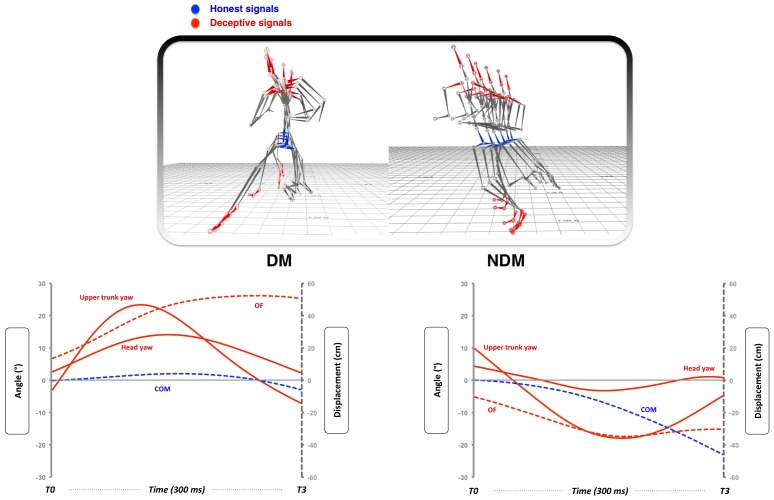
Dynamics of deception.The skeletal representations in the top two panels show how a deceptive (DM – left panel) and non-deceptive (NDM – right panel) movement unfold during the attacking player’s approach run. Each image represents a given moment in time during the unfolding movement and shows how the honest (blue) and deceptive (red) signals evolve during the movement. The graphs below show how during a deceptive movement the displacement of the honest signal (Centre of Mass (COM) displacement) is minimised whilst the displacement of the deceptive signals (i.e. Upper trunk yaw, Out Foot (OF) displacement and Head yaw) are all maximised. The non-deceptive movement (NDM) has a very different profile with all key body signals moving in a similar direction as the movement unfolds.